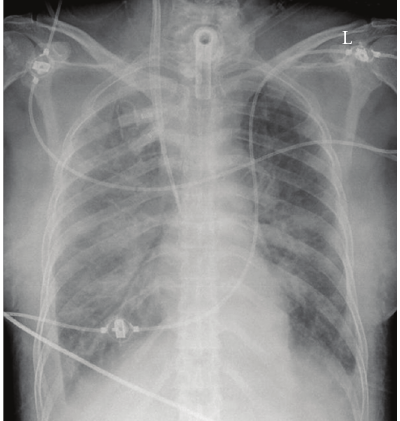
Figure 2: The chest X-ray on ICU admission reveals pulmonary